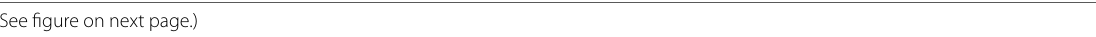
(See figure on next Fig. 3 Conventional light and CLSM images showing the formation of new periderm (Stage 1) in Tree B in June, 2016. a , c Light micrographs of a transverse section without staining. b , d CLSM images of the same section as in a , c after stained with FY and CR. Light micrographs of radial sections stained with acetocarmine ( e , f ) and iodine–potassium iodide ( g ), showing nuclei (black arrowheads) and starch grains, respectively. c , d , f Higher magnification images of the selected areas in a , b , e . Black arrows indicate axial and ray parenchyma cells with no nuclei. White arrows indicate new periderm. White arrowheads indicate new periderm with no starch grains. AP axial parenchyma cell, F phloem fiber, IB inner bark, NPr new periderm, NRh new prhytidome, Pr periderm, Rh rhytidome, RP ray parenchyma cell. The right side of each micrograph corresponds to the outer side of the tree. Scale bars 200 µm in a , b , e ; 100 µm in f , g ; 50 µm in c , d =